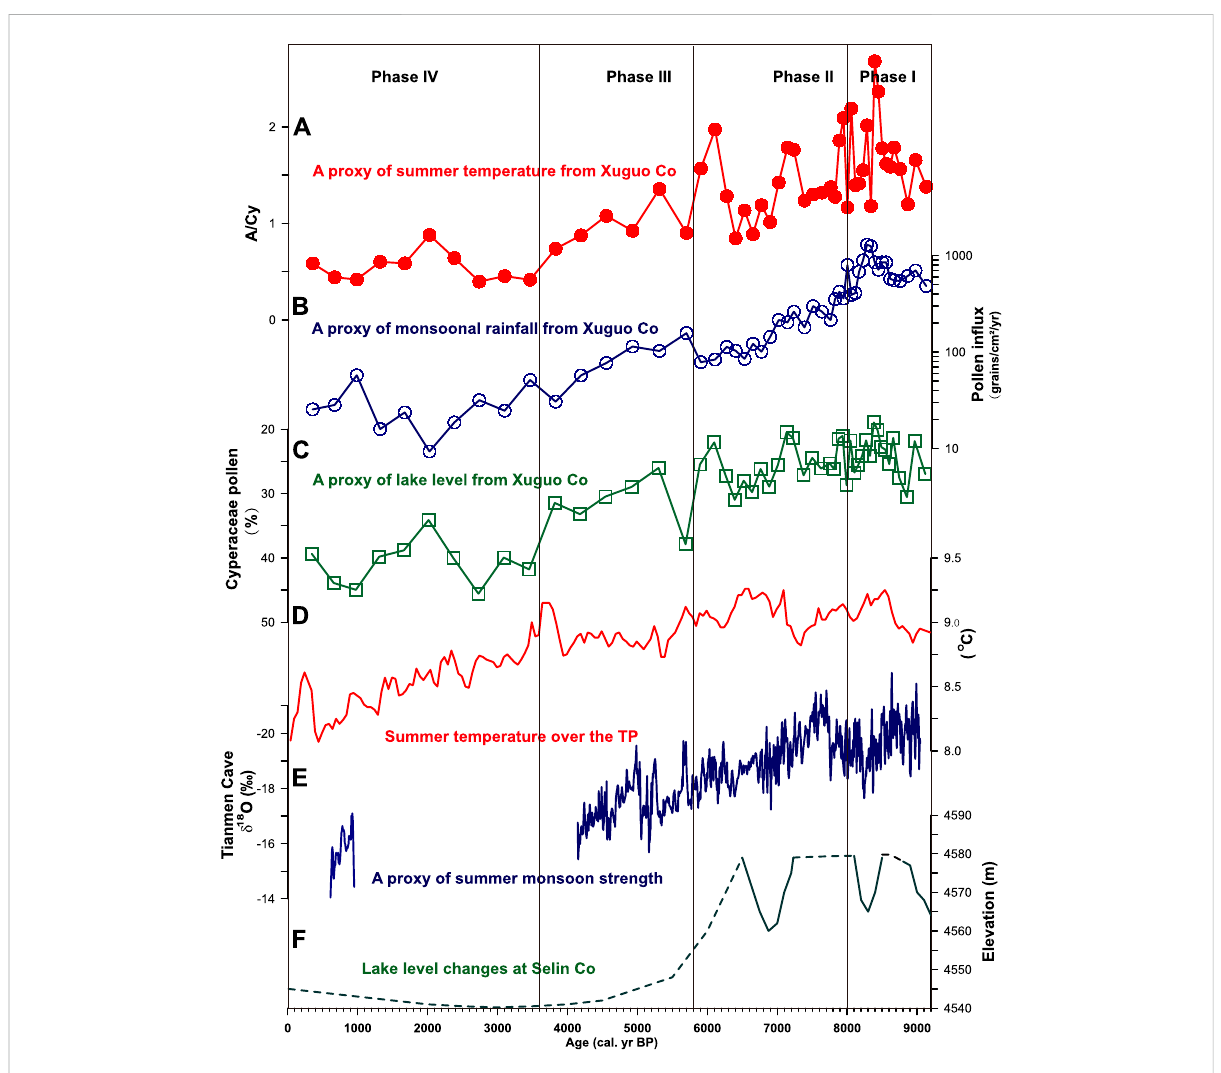
FIGURE 6 Comparison of proxies of summer temperature (A) , monsoonal rainfall (B) , and lake level (C) derived from the fossil pollen record of Xuguo Co withHolocenesummertemperaturechangeovertheTPreconstructed byasynthesisoffossilpollenrecords[ (D) ,Chenetal.,2020],stalagmite δ 18 O as a proxy of ISM strength from Tianmen Cave in Baingo [ (E) , Cai et al., 2012], and lake-level change at Selin Co [ (F) , Hou et al.,